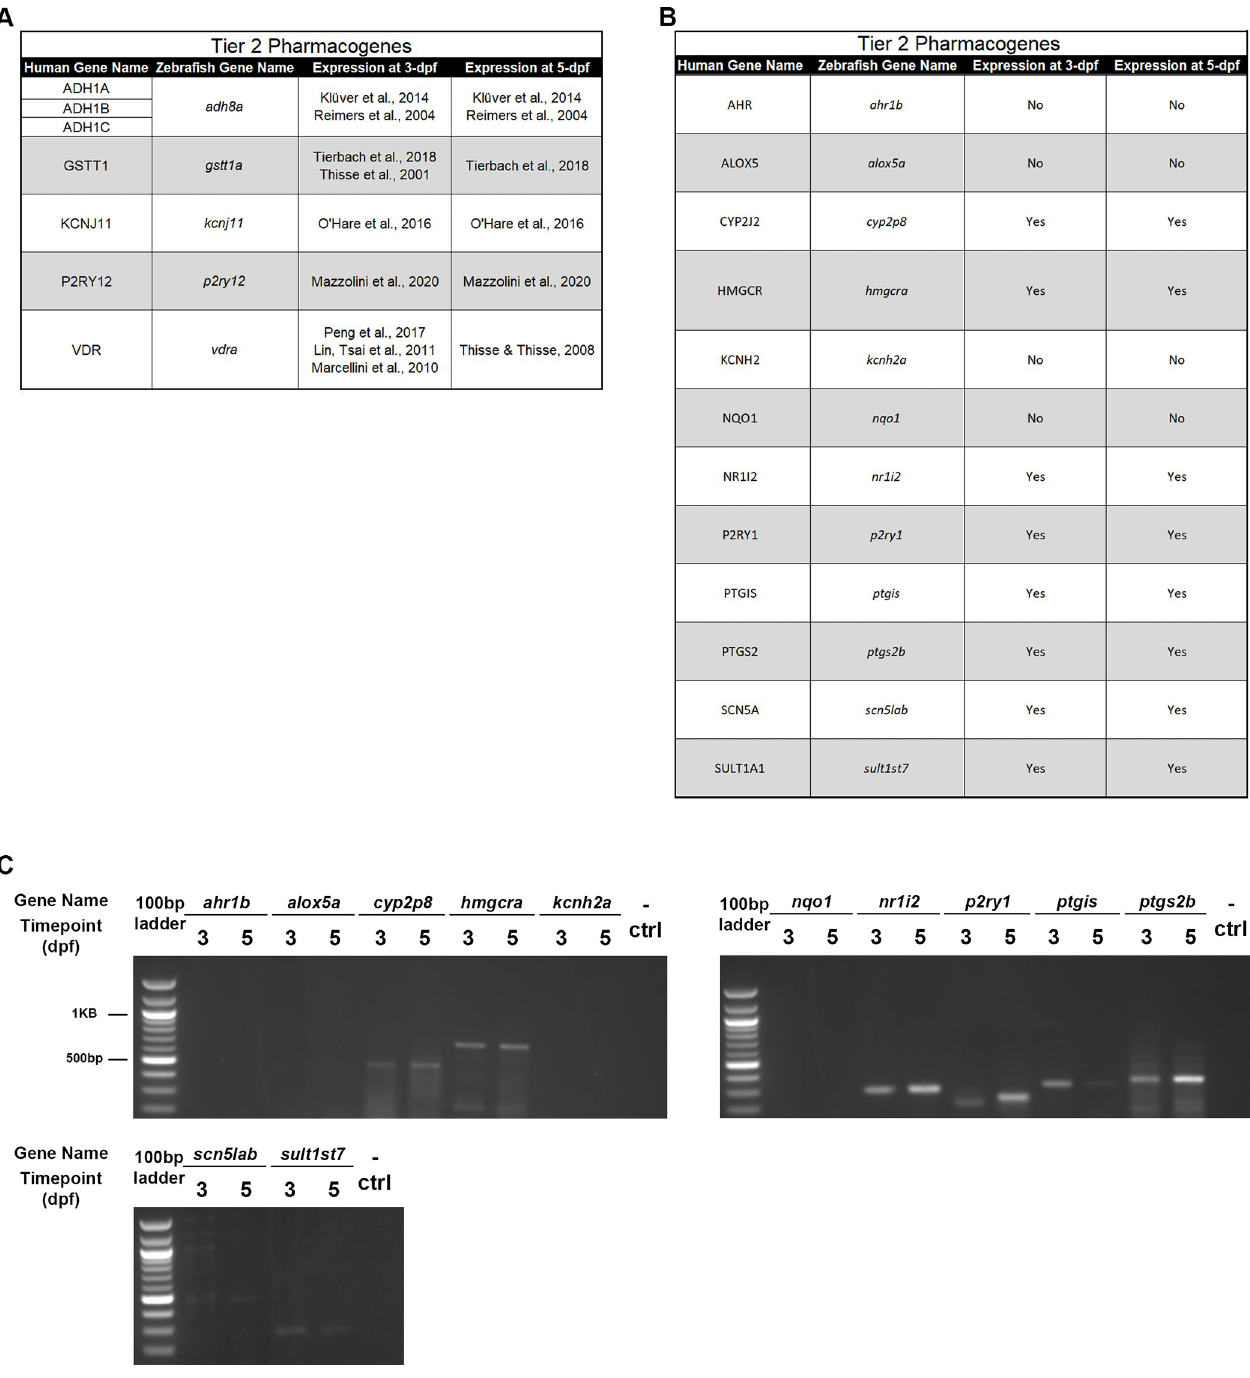
PLOS ONE | https://doi.org/10.1371/journal.pone.0273582 August 30, 2022 8 /